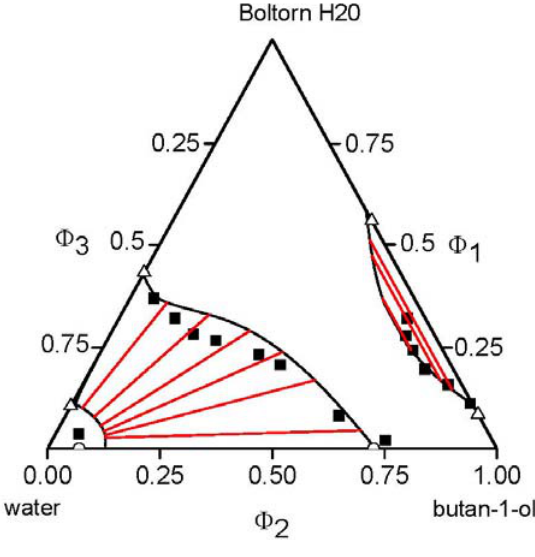
Figure 11. Experimental (solid squares, [58]; open circles [129], open triangles interpolation from the binary data [54,58]) and predicted (lines) ternary phase behaviour of Boltorn H20 + water + butan-1-ol at 353.15 K using LCT in combination with Wertheim lattice theory. The red lines are tie